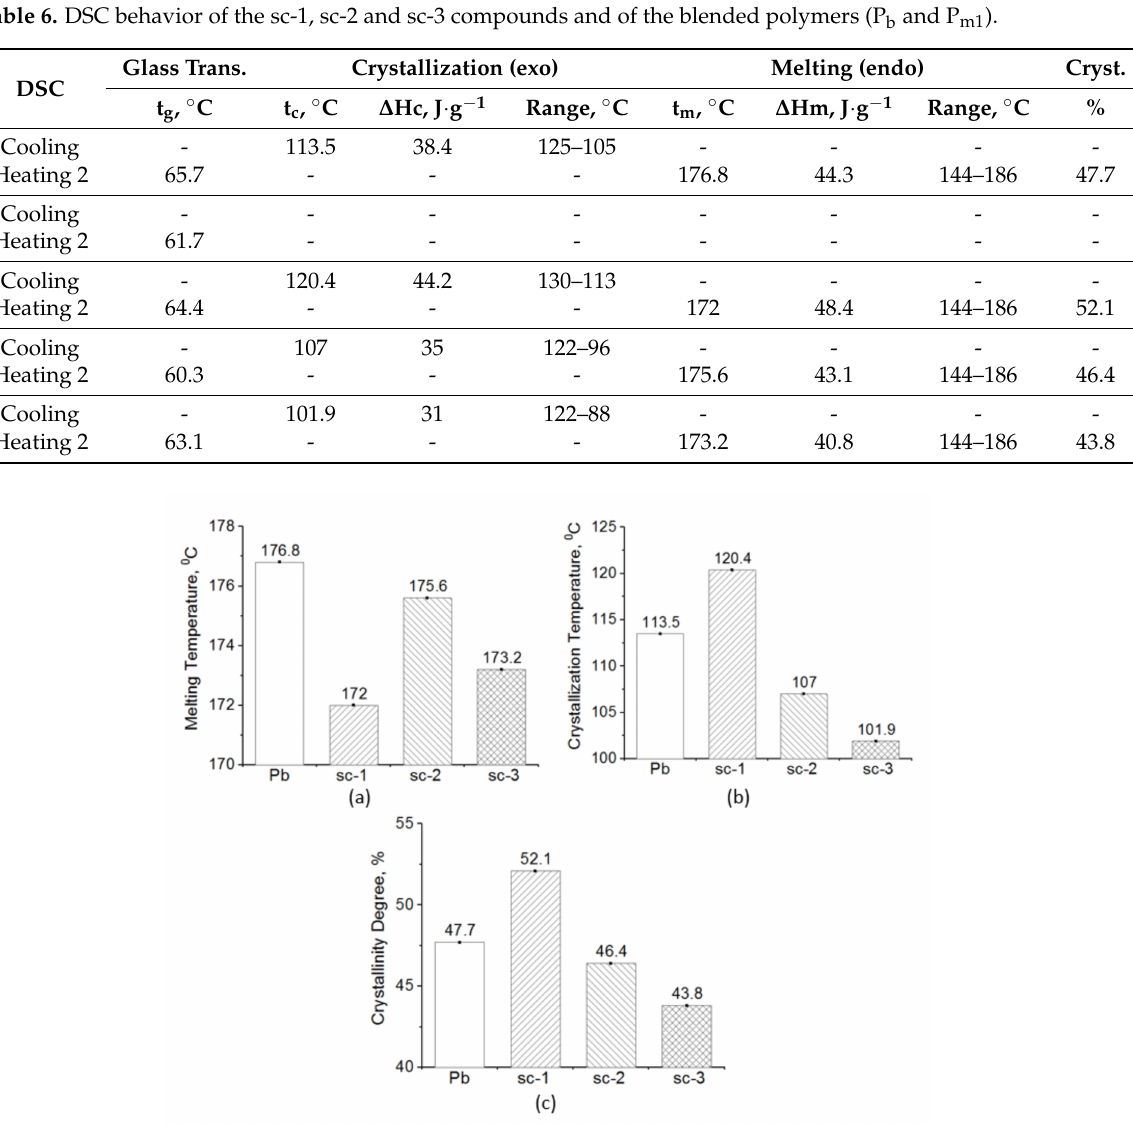
Figure 7. Thermal properties of the sc-1, sc-2 and sc-3 compounds vs. base-PLLA: melting tempera- ture ( a ), crystallization temperature ( b ) and crystallization degree ( c